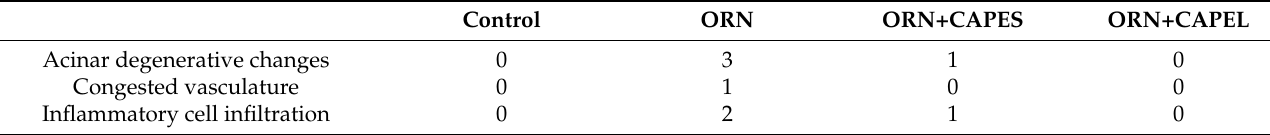
Values represent the predominant histological grading in each experimental group ( n =